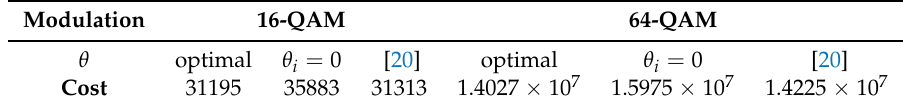
Figure 3. The value of the weighted Ω terms that depend on the rotation angle (left y-axis) and the value of the rotation-independent Ω 1 (right y-axis) for n R = 3 and 16-QAM ( left sub-figure ) and 64-QAM ( right sub-figure ). Table 3. A comparison between the minimum value, maximum value, and the one corresponding to the angles in [20] of the cost function in (21) for 16 and 64-QAM with n R =